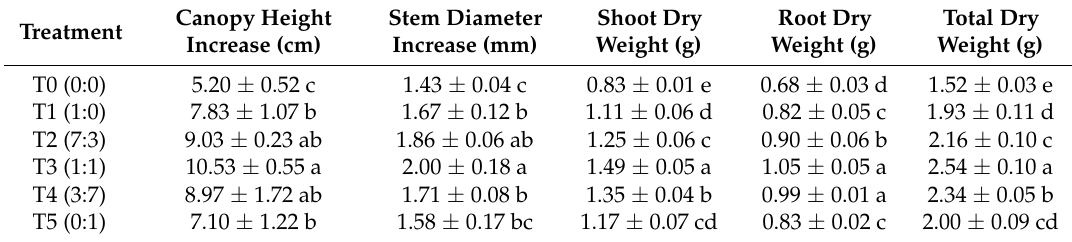
Table 2. The growth and biomass accumulation of Camellia oleifera ‘Xianglin 27’ seedlings fertigated with six nutrient solutions varying in NO 3 − to NH 4+ ratios.